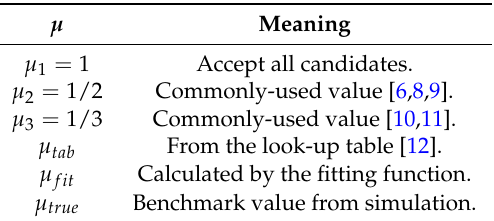
Table 2. The notation of µ from different